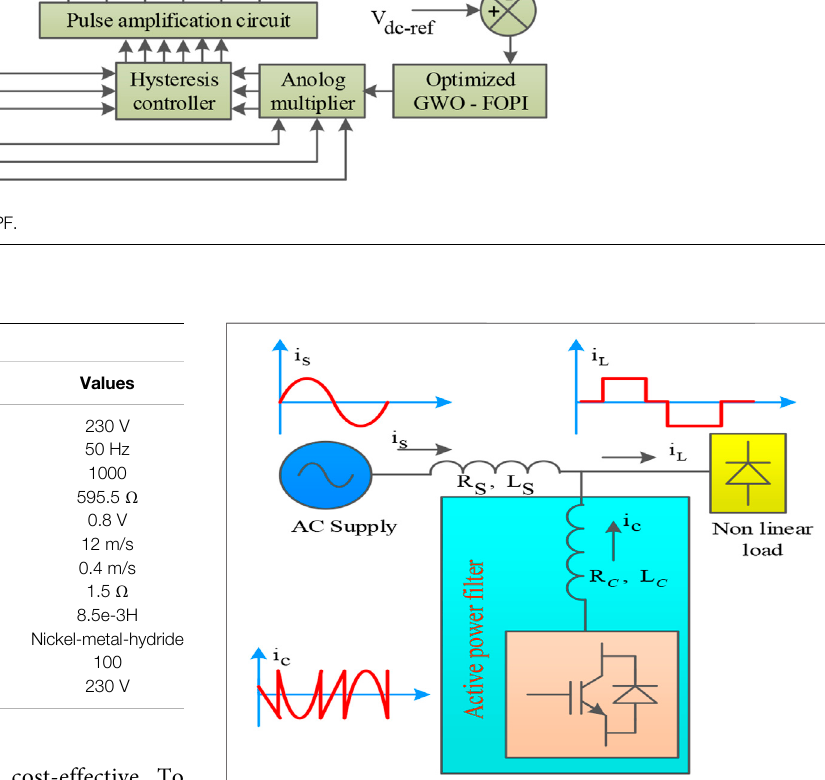
FIGURE 3 | Basic structure of shunt APF.